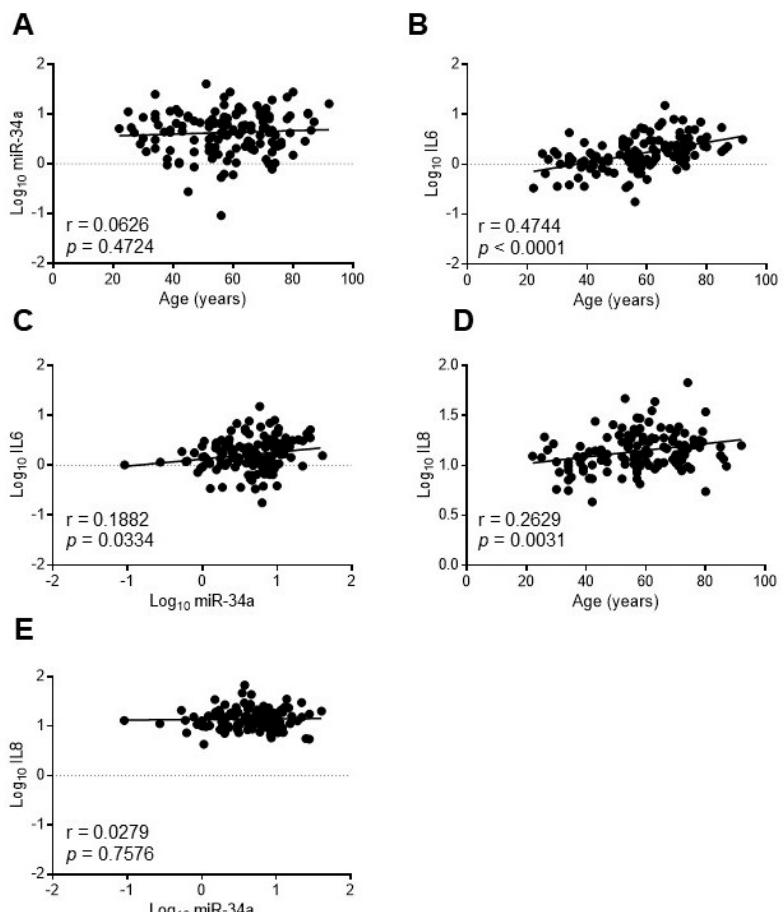
Figure 6. IL6 but not IL8 levels correlate with miR34a expression in healthy subjects. The expression levels of miR-34a were evaluated by qRT-PCR and IL6 or IL8 by ELISA in the serum of 20-90 years-old healthy subjects. Scatter plots showing correlation between age and miR-34a ( A ), age and IL6 ( B ), miR34a and IL6 ( C ), age and IL8 ( D ), miR-34a and IL8 ( E ). Variables showed a skewness distribution and were log-transformed. r = Pearson’s coefficient; n = 127–128.